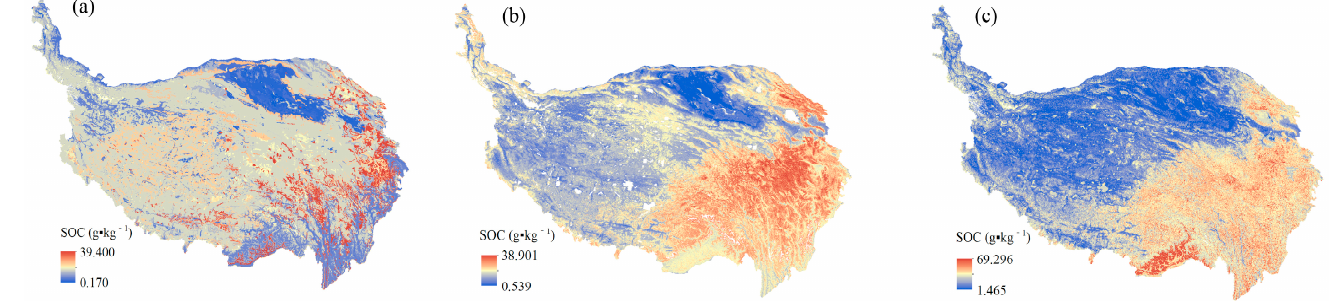
Figure 7. Comparison of SOC mapping results with the existing maps (( a ) HWSD, ( b ) Li’s prediction, ( c ) Our prediction).